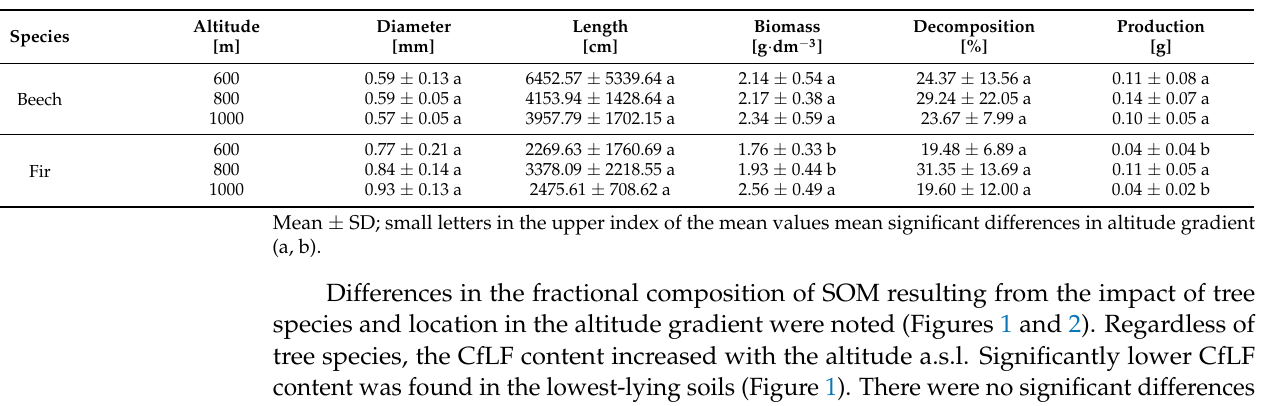
Table 2. Characteristics of the fine roots of different tree species in the altitude